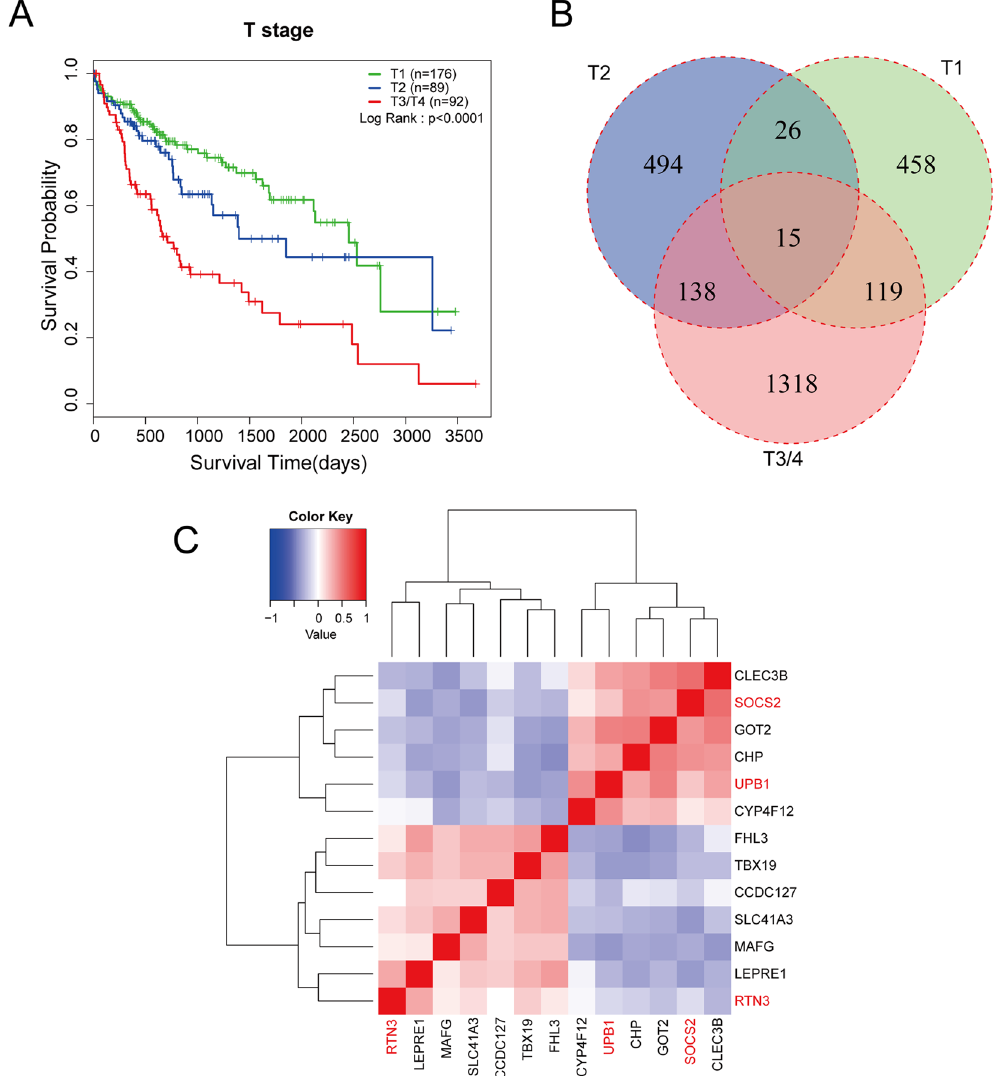
Figure 2. Identification of prognostic genes with T stage stratification. ( A ) Kaplan-Meier curve for overall survival in HCC patients with different T stages from TCGA LIHC dataset. Patients were divided into 3 groups according to the T stages (T1, n = 176; T2, n = 89; T3 and T4, n = 92). Advanced T stage is a significant factor for poor prognosis (p < 0.0001, log-rank test). ( B ) All HCC patients were divided into three groups based on the T stages, and Kaplan-Meier survival analysis was performed in each group separately. Two subgroup were separated on the basis of the median expression level of each gene. 617 survival-related genes were obtained from T1 group, and 672 genes from T2 group, 1590 genes from T3/4 group. 15 common genes were found in different groups. ( C ) Cluster analysis of the 13 survival related genes based on the spearman correlation coefficient. The color in the heatmap represents spearman correlation coefficient. Red indicates positive correlation, and blue indicates negative correlation. 13 genes were clustered into 4 clusters, and RTN3, SOCS2, UPB1 (marked in red) were in different